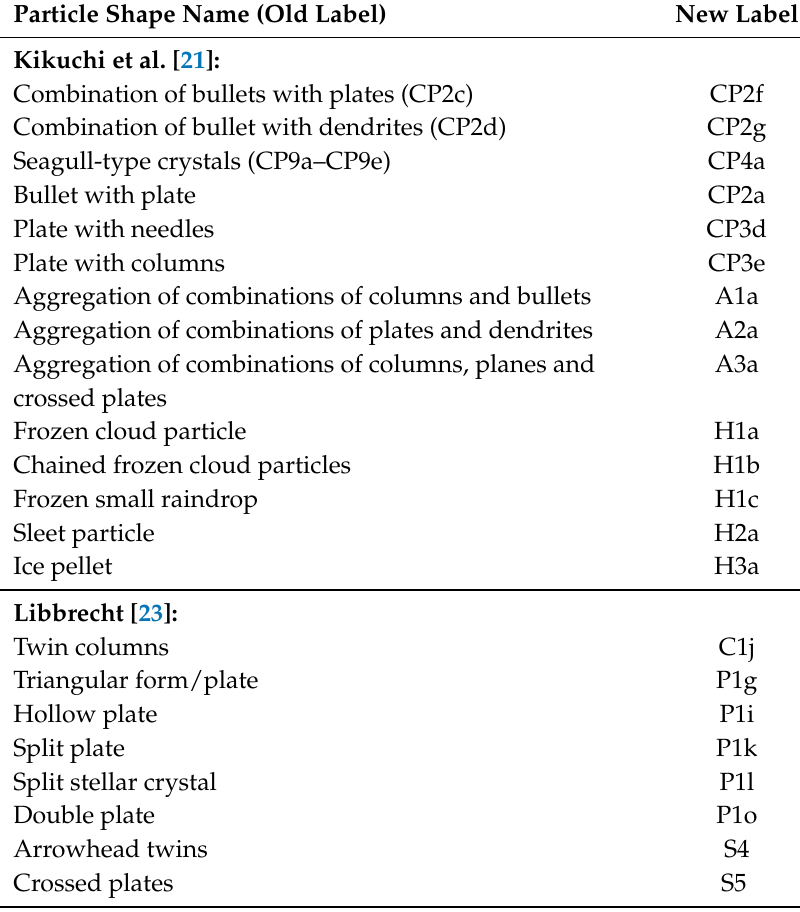
Table 1. Added shapes from Libbrecht [23] and Kikuchi et al.